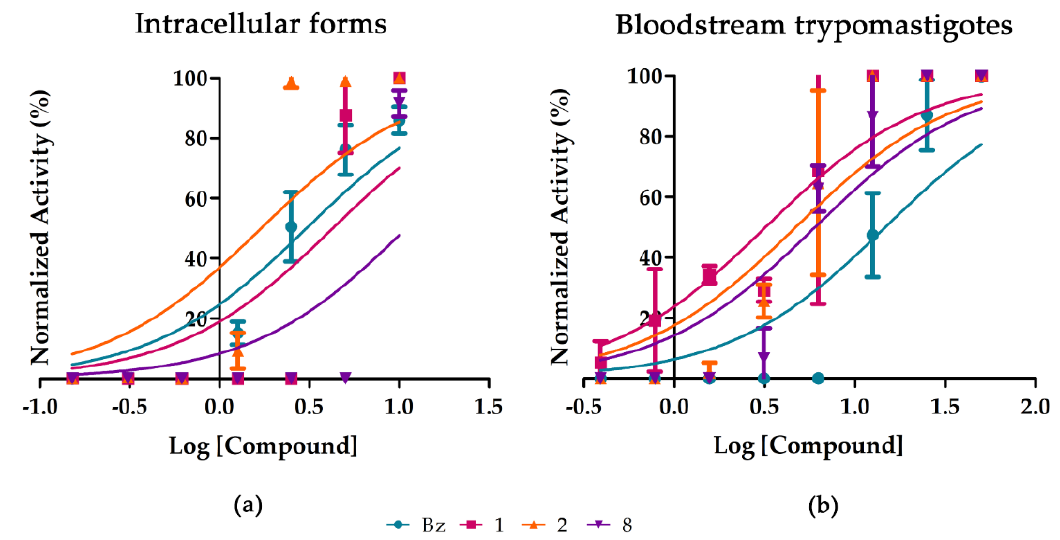
Figure 3. Activity of compounds 1 , 2 and 8 against intracellular forms of Tulahuen strain ( a ) and on bloodstream trypomastigotes of Y strain ( b ) after 24 and 96 h of incubation, respectively. The X-axis shows log of compound molar concentrations (M), and Y-axis shows the normalized activity. Table 4. Activity of the purified substances against intracellular and bloodstream forms of T. cruzi (EC 50 μM) mammalian cell’s toxicity (L929 cell lines 1 and cardiac cell cultures 2 -LC 50 , μM) and cor- responding Selectivity Indexes (SI).